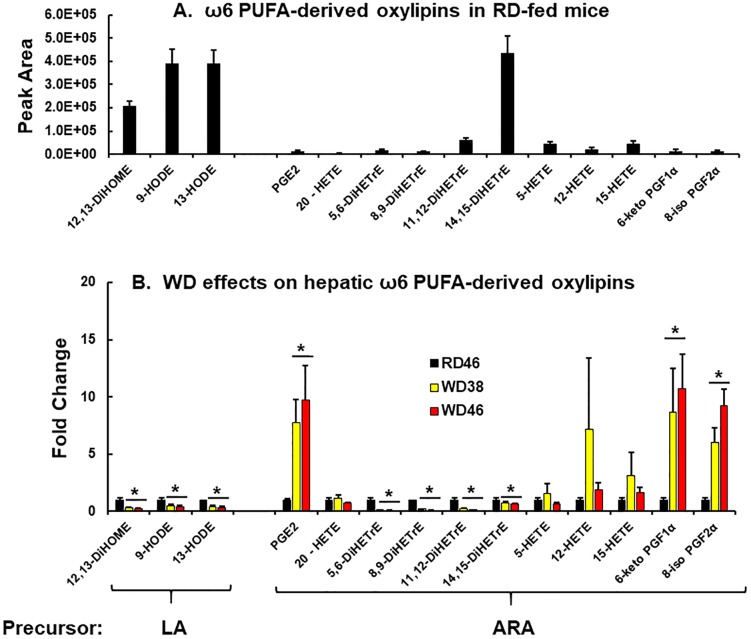
Western diet effects on hepatic ω6-PUFA derived oxylipins.ω6-PUFA derived oxylipins were quantified using a targeted LC/MS approach (Materials and methods). A: ω6 PUFA-derived oxylipins in RD-fed mice. B: Diet effects on ω6 PUFA-derived oxylipins. Results are presented as fold change in oxylipins induced by the WD. (mean ± SEM, N = 7–8 samples), *, FDR <0.05 versus the RD46 group. DiHOME, dihydroxyoctadecaenoic acid; HODE, hydroxyoctadecaenoic acid; PGE, prostaglandin E; PGF, prostaglandin F; HETE, hydroxyeicosatrienoic acid; DiHETrE, dihydroxyeicosatrienoic acid; LA, linoleic acid; ARA, arachidonic acid.